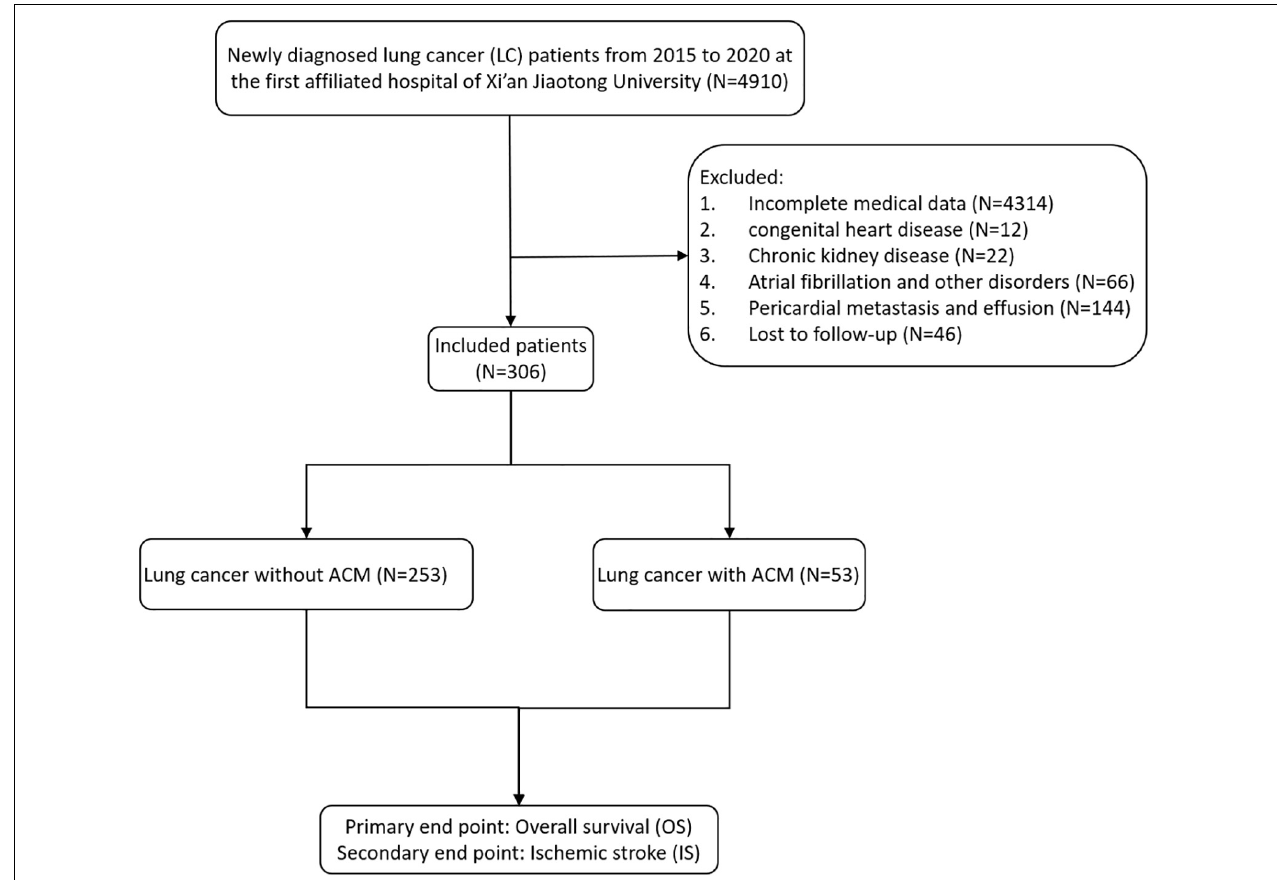
FIGURE 1 | Flowchart detailing patient